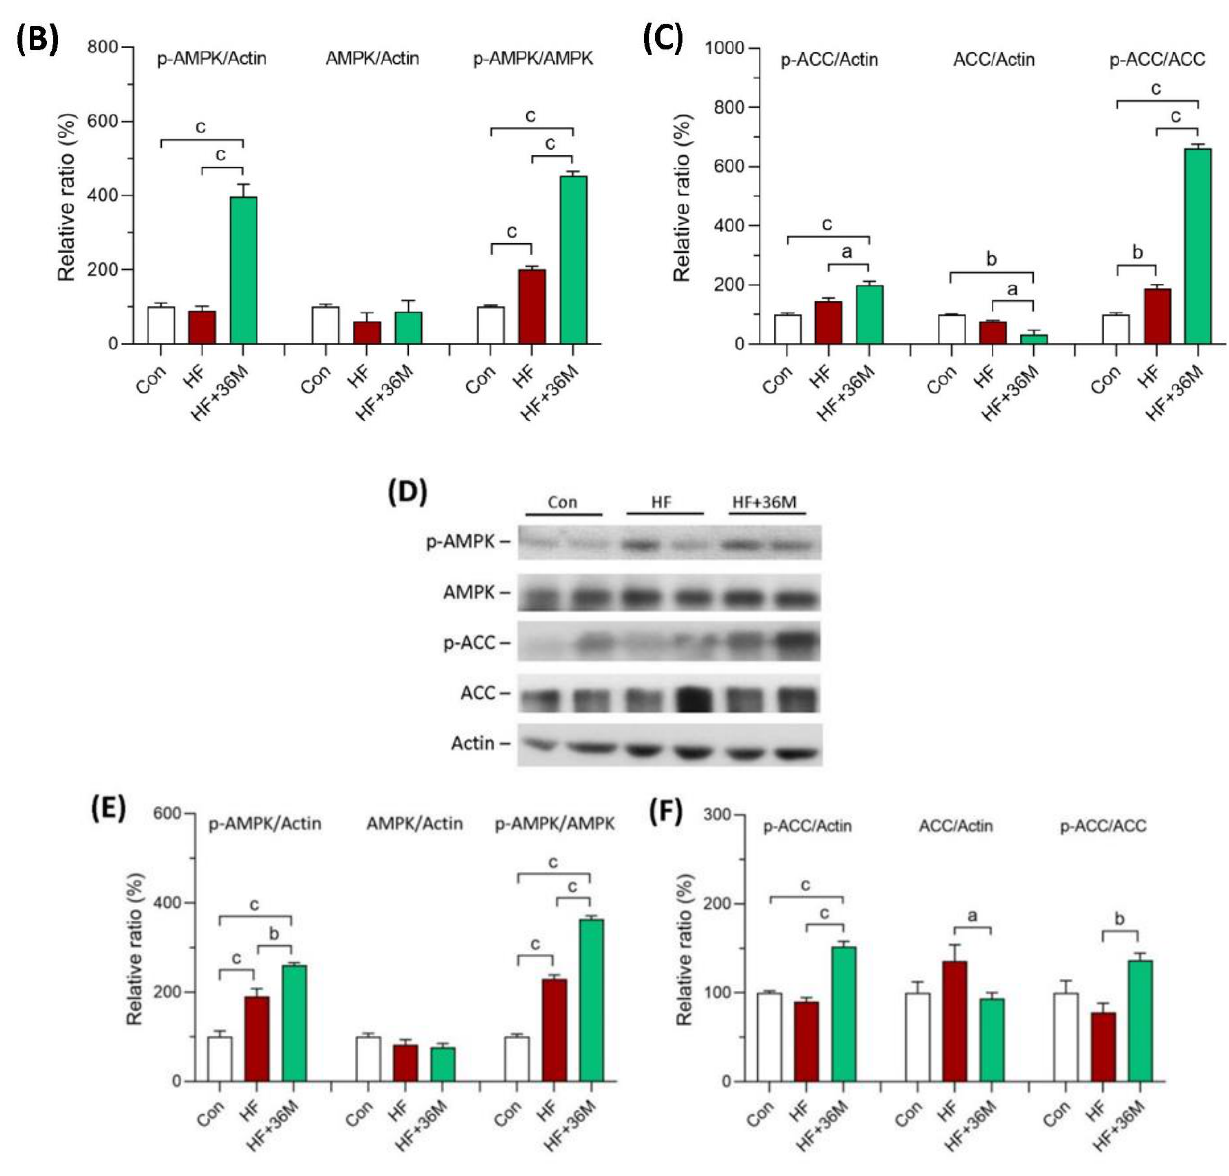
Figure 8. AMPK protein expression in liver of the mice. ( A ) The representative immunoblot images for p-AMPK, AMPK, p-ACC, ACC, and β -actin proteins of the mice in the prevention model. ( B , C ) The quantified results of the blots. ( D ) The representative immunoblot images for p-AMPK, AMPK, p-ACC, ACC, and β -actin proteins of the mice in the treatment model. ( E , F ) The quantified results of the blots. These protein expressions were detected by Western blotting. Con: control; HF: high-fat diet. Data are mean ± SE (n = 8). a: p < 0.05; b: p < 0.01; c: p < 0.001.